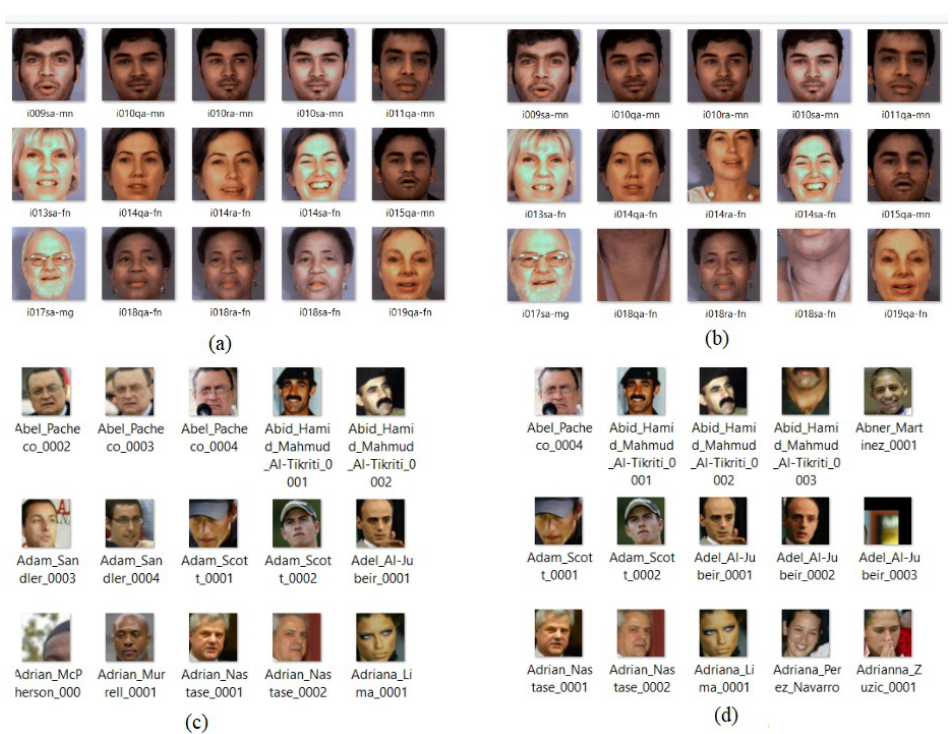
Figure 10. Faces detected by ( a ) Haar-like and ( b ) LBP custom face detector at 0.1 FAR for 8-layers of cascade stages. Subimages ( c , d ) are the output from ResNet101 and ResNet50,